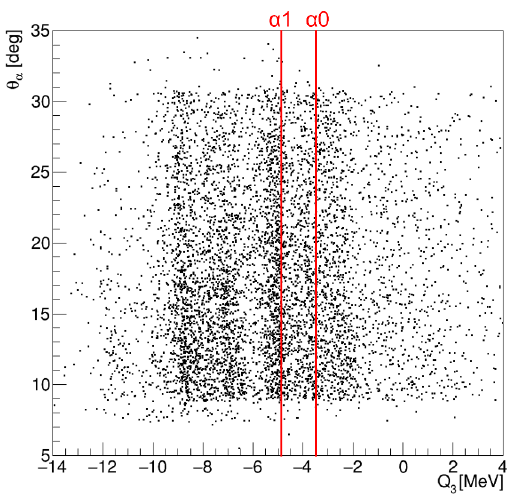
Figure 1. Detection angle of the alpha particle vs experimental Q-value for the 16 O( 14 N ,α 24 Mg) 2 H reaction channel. Black dots represent the experimental data, while red lines represent the theoretical value for both the ground state ( α 0) and the first excited state ( α 1). From Ref. [12] with kind permission of Società Italiana di